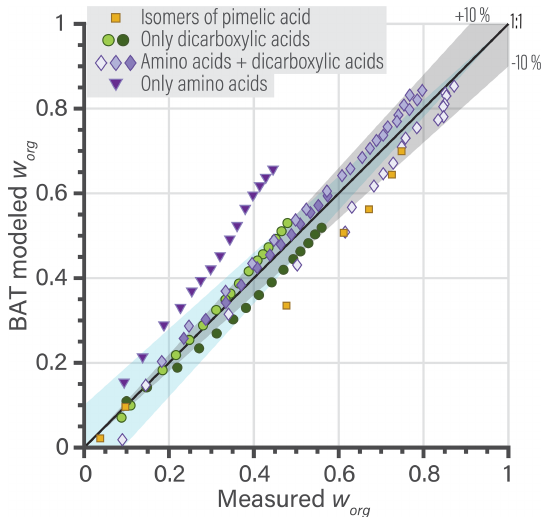
Figure 12. Single-component organic aerosol measurements of κ CCN are compared against those predicted by corresponding BAT model simulations of CCN activation. The gray shading repre- sents ± 42% average uncertainty in the measured κ CCN . The dashed line is a linear fit with a zero intercept, κ CCN , BAT = κ CCN , measured × 0 . 799 [± 0 . 059 ] with a Pearson’s R 2 of 0 . 66. The model–measurement RMSE was 0.055. The BAT simulations as- sume a 100nm diameter equivalent volume of organic matter at the CCN activation point. The droplet surface tension is calculated as a volume-weighted mean. A list of the 30 measurement points is given in Table S6 of the Supplement, with the data obtained from the following studies: Broekhuizen et al. (2004); Brooks et al. (2004); Petters et al. (2006, 2009, 2016); Petters and Kreidenweis (2007); Frosch et al. (2010); Huff Hartz et al. (2006); Pradeep Kumar et al. (2003); Raymond (2003); Suda et al. (2014), and Svenningsson et al.